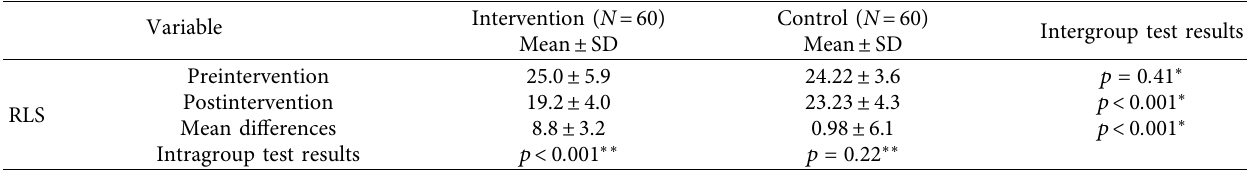
Table 2: The mean score of RLS before and after intervention in participants of both groups.